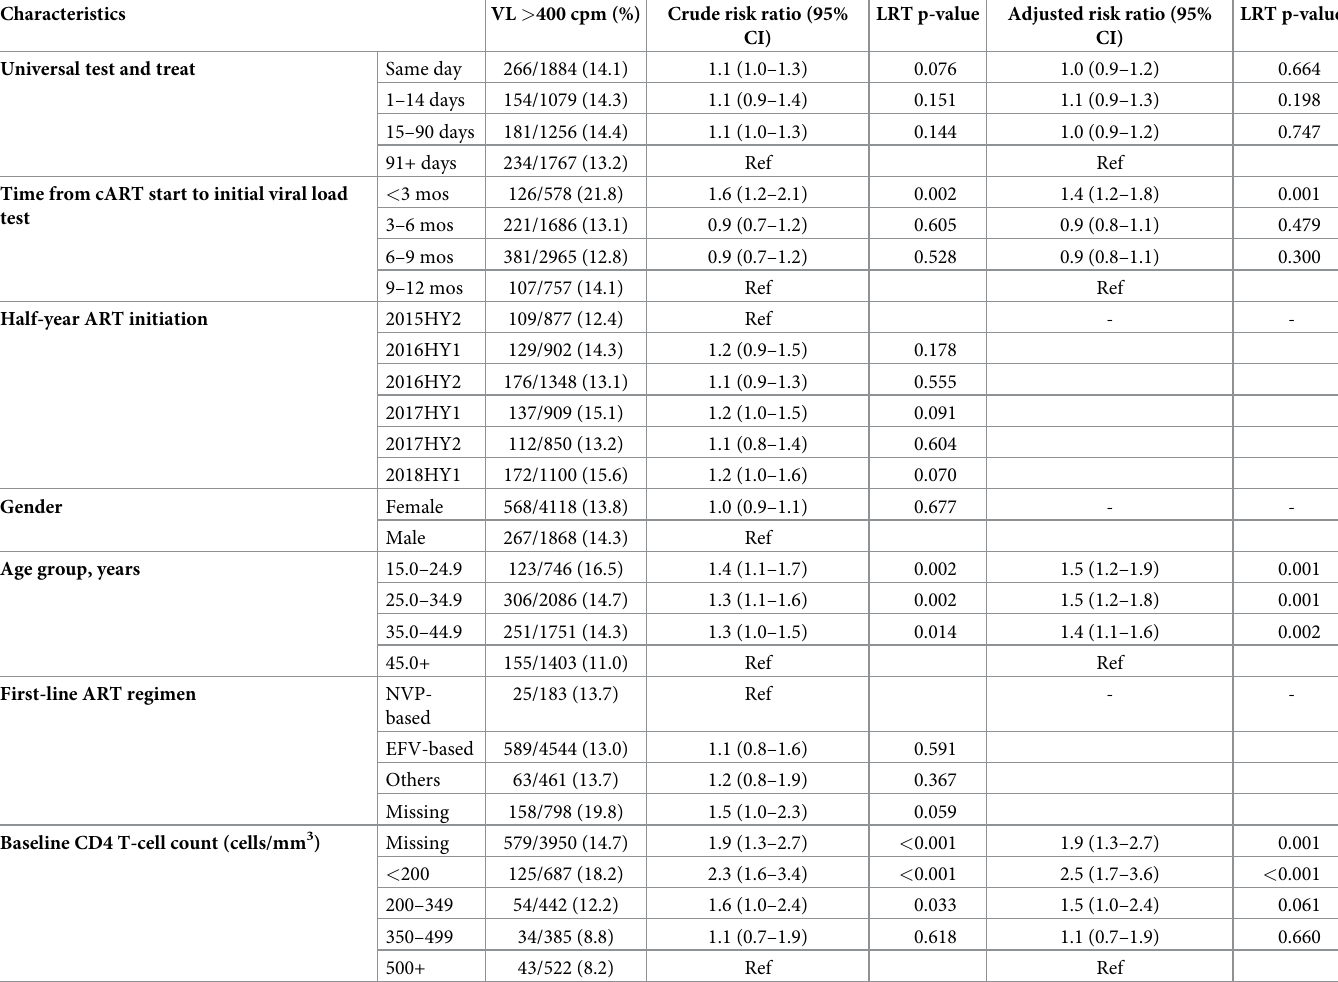
Fig 4. Graph showing initial virologic non-suppression (first available viral load test results of > 400 copies per ml) stratified by universal test and treat, defined as same day, 1–14 days, 15–90 days and 91+ days from a HIV diagnosis to combination antiretroviral therapy start, amongst HIV infected adults starting combination antiretroviral therapy using data from the national data warehouse in Kenya (2015HY2 to 2018HY1, N = 5986). https://doi.org/10.1371/journal.pone.0277675.g004 Table 4. Effect of universal test-and-treat, defined as same day, 1–14 days, 15–90 days and 91+ days from a HIV diagnosis to combination antiretroviral therapy start, on initial virologic non-suppression (first available viral load test results of > 400) amongst HIV infected adults starting combination antiretroviral therapy and captured in the national data warehouse in Kenya (2016-HY2 to 2018-HY1, N = 5986).